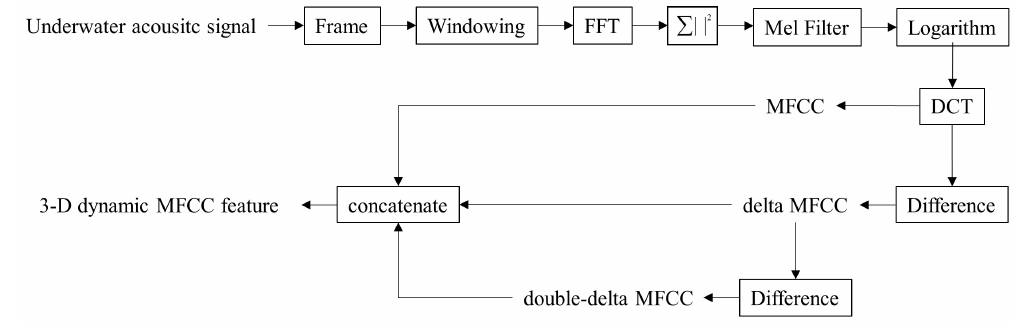
Figure 4. The 3D dynamic MFCC feature extraction block diagram.